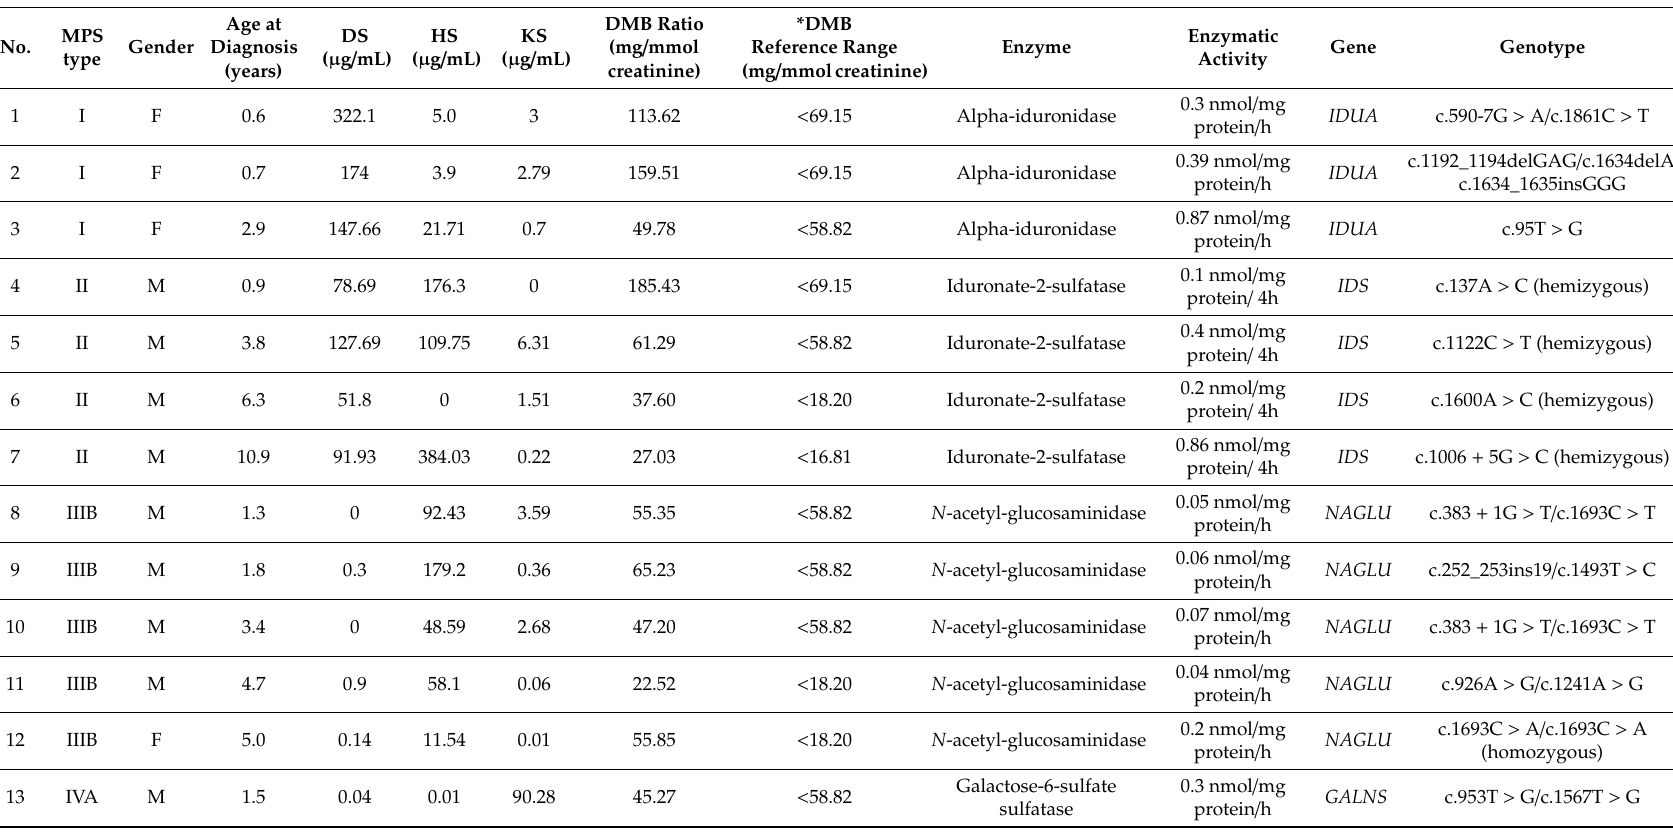
Table 4. Demographic data, urine glycosaminoglycans (GAG) levels, enzymatic activity, and genotype of the 13 MPS patients at the time of a confirmative diagnosis.